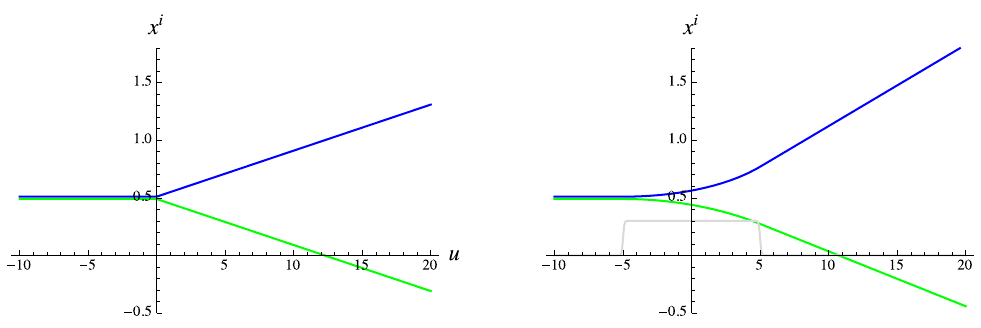
Figure 6 . These plots show the behaviour of the transverse coordinates x 1 ( u ) and x 2 ( u ) of a geodesic in the neighbourhood of (cid:13) (with x i = 0) through the encounter with a gravitational wave burst. The green curves denote x 1 ( u ) and exhibit an initial focusing followed by divergence, while the blue curves denoting x 2 ( u ) show a divergence. The left-hand (cid:12)gure refers to the Penrose limit plane wave with impulsive pro(cid:12)le (cid:31) F ( u ) = (cid:14) ( u ), while the right-hand (cid:12)gure describes the case of an extended pro(cid:12)le (cid:31) F ( u ) = (cid:2)( u; L ).